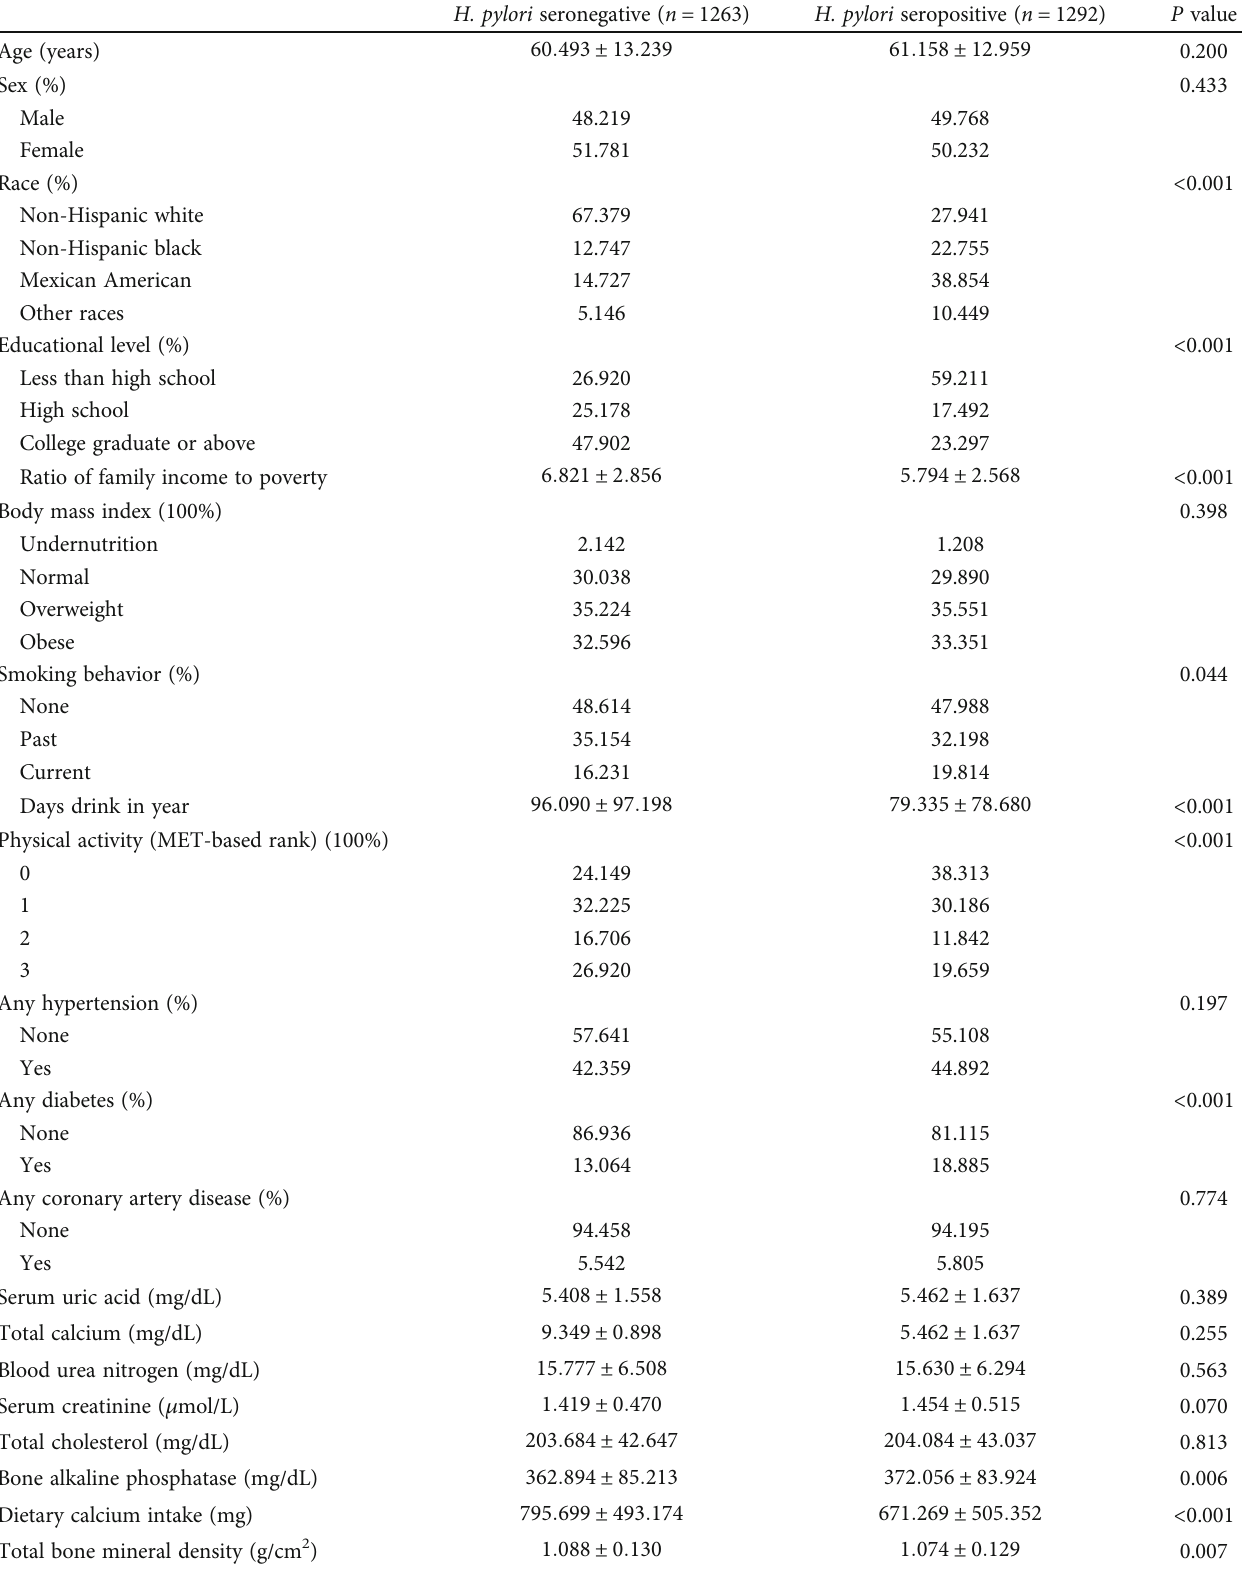
Table 1: Weighted characteristics of included